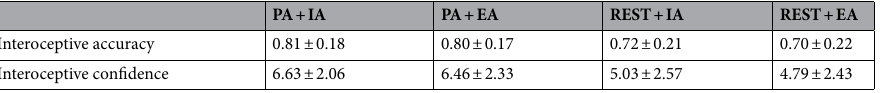
Table 2. Means and standard deviation scores for the interoceptive accuracy and interoceptive confidence scores across all four conditions. PA + EA physical activity with an exteroceptive focus, PA + IA physical activity with an interoceptive focus, REST + EA exteroceptive focus at rest, REST + IA interoceptive focus at rest.